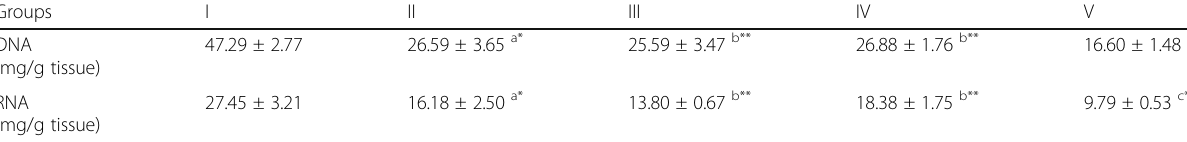
Table 3 Effect of aqueous extract of Caesalpinia bonducella L. on DNA and RNA in experimental animals Groups